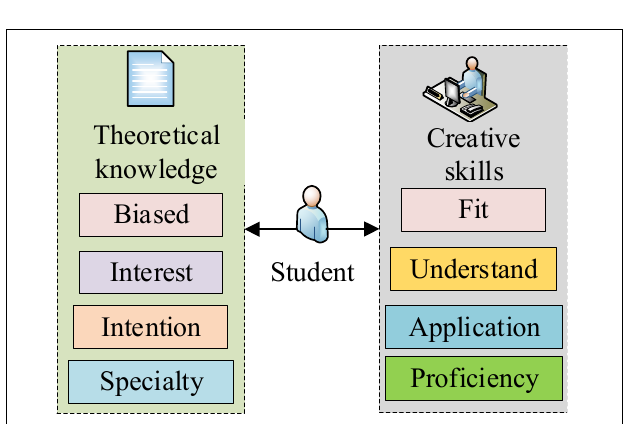
FIGURE 3 | EPSY-based Cinematography